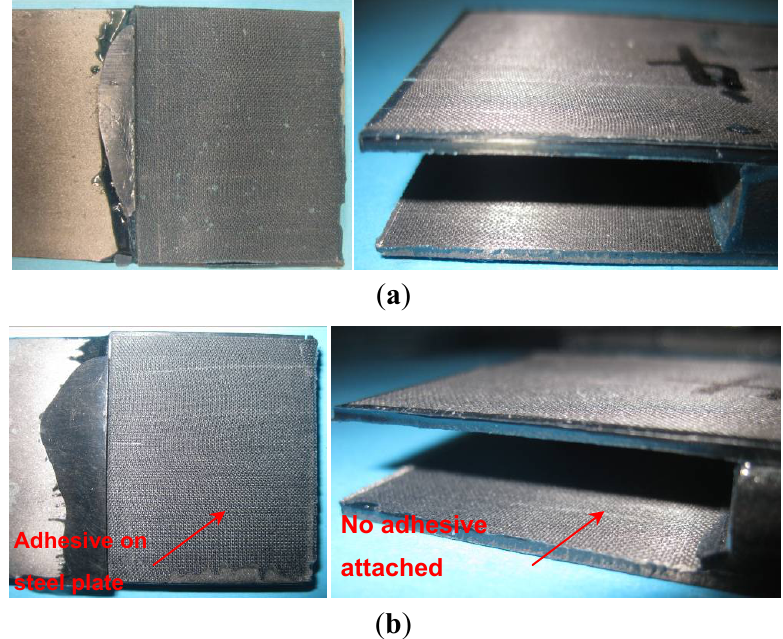
Figure 7. Failure modes of DJL specimens with ( a ) original epoxy adhesive (DJL0-4); and ( b ) epoxy with 5% MCF weight ratio